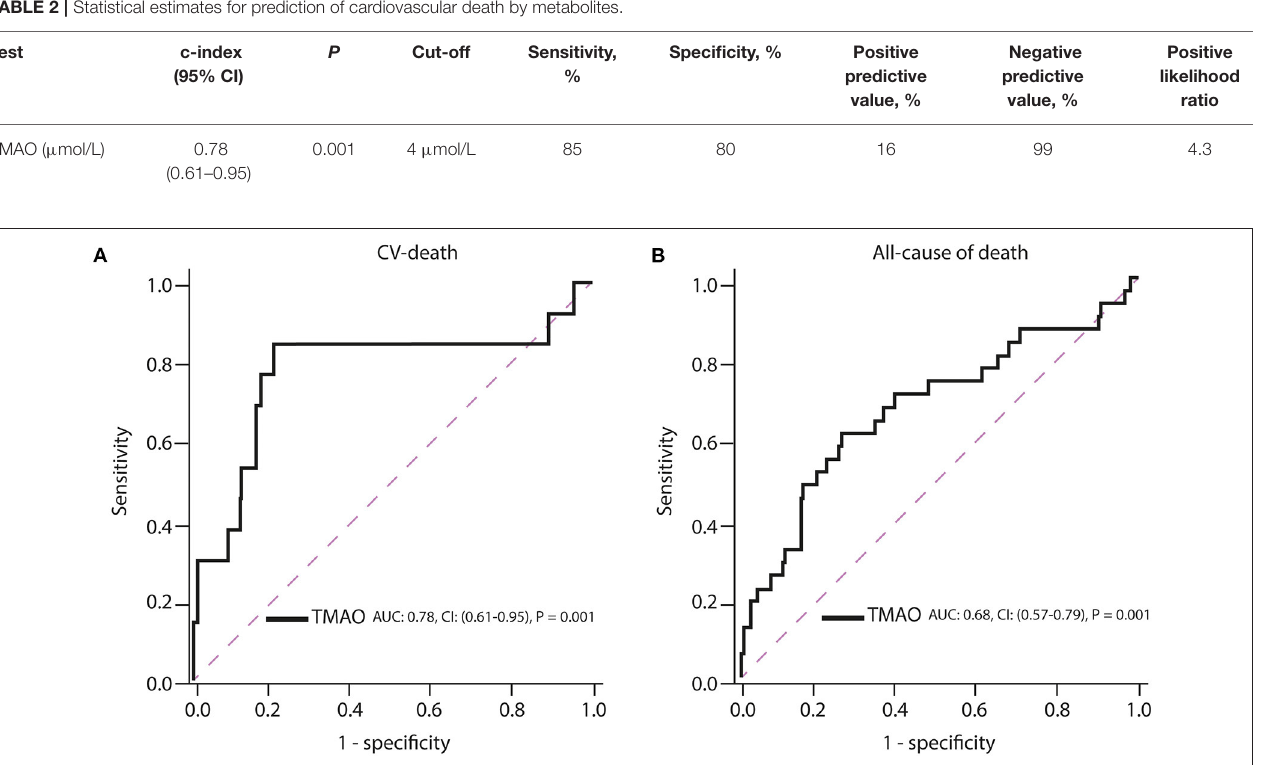
number of studies and meta-analyses confirmed the association between higher concentration of TMAO and higher risk of MACE, including CV and all-cause death and mortality during follow-up periods of up to 4 years (14, 21, 41–46). Interestingly, higher levels of TMAO were related to increased incidence of all-cause mortality in a dose-dependent manner, namely 7.6%